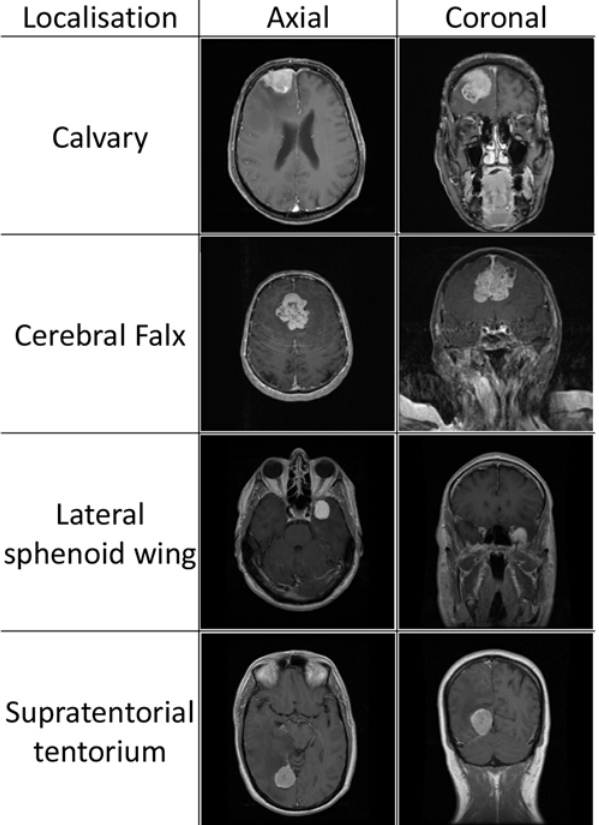
Fig 1. Meningioma location. Exemplary images of meningioma location to demonstrate assessment of location of the tumor as easily accessible in this study.